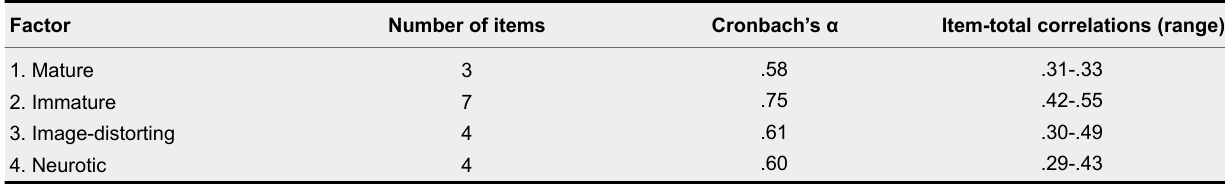
Internal Consistency Indices for the Four Subscales of the Greek-Adapted Version of DSQ-40 (Ν = 265) Factor Number of items Cronbach’s α